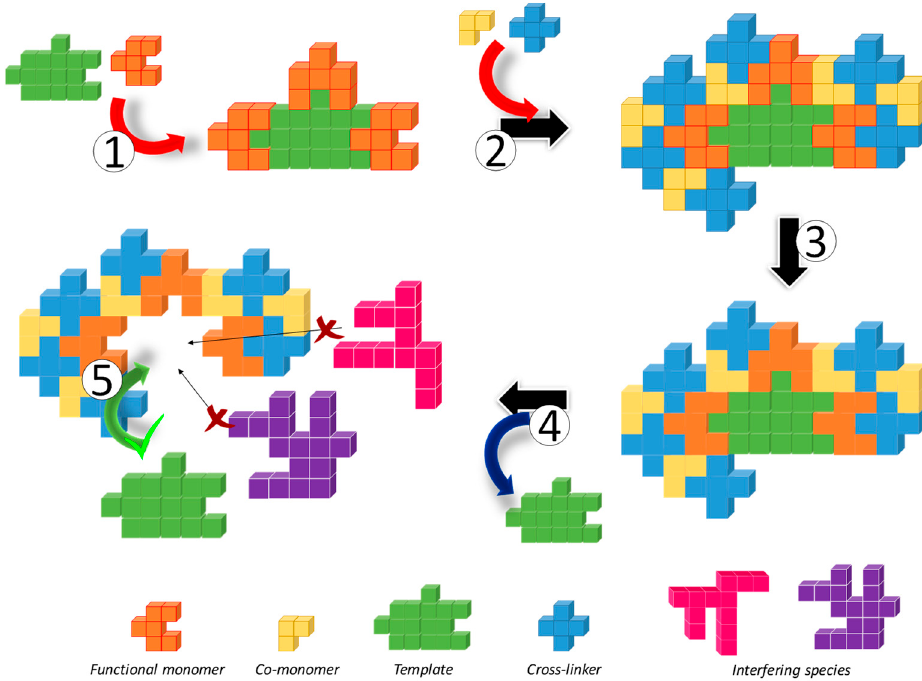
Figure 1. Scheme for the preparation of a Molecularly Imprinted Polymer (MIP). (1) First, template molecule (T) and functional monomers (FM) are mixed to get the complex FM-T. (2) The rest of the components of the pre-polymerization mixture are added, i.e., co-monomers (CM) and cross-linker (CL). (3) After the addition of a radical initiator (thermal or photochemical) or a catalyst (acid or base), polymerization takes place. (4) T is removed resulting in a pocket within the polymeric matrix. (5) T re-binds the selective cavity while other potential interfering species are blocked due to limitations in terms of size, shape and/or functional groups distribution.